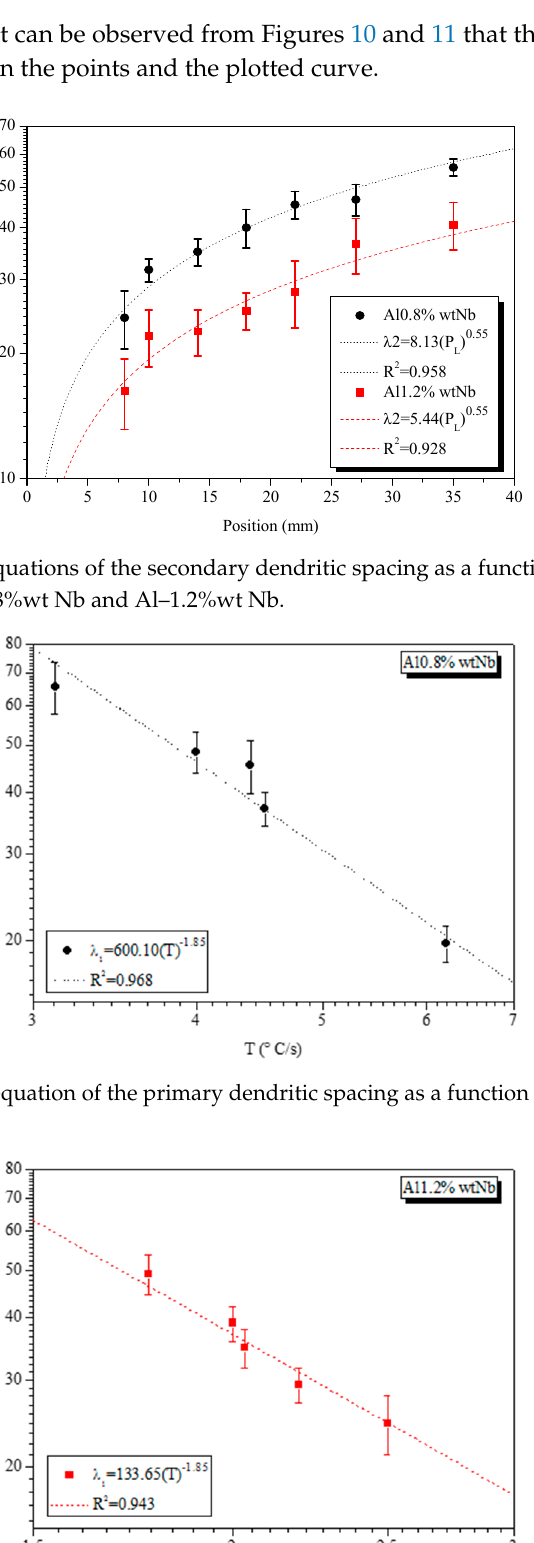
Figure 11. Experimental equation of the primary dendritic spacing as a function of the cooling rate for Al–1.2 Nb (wt.%).